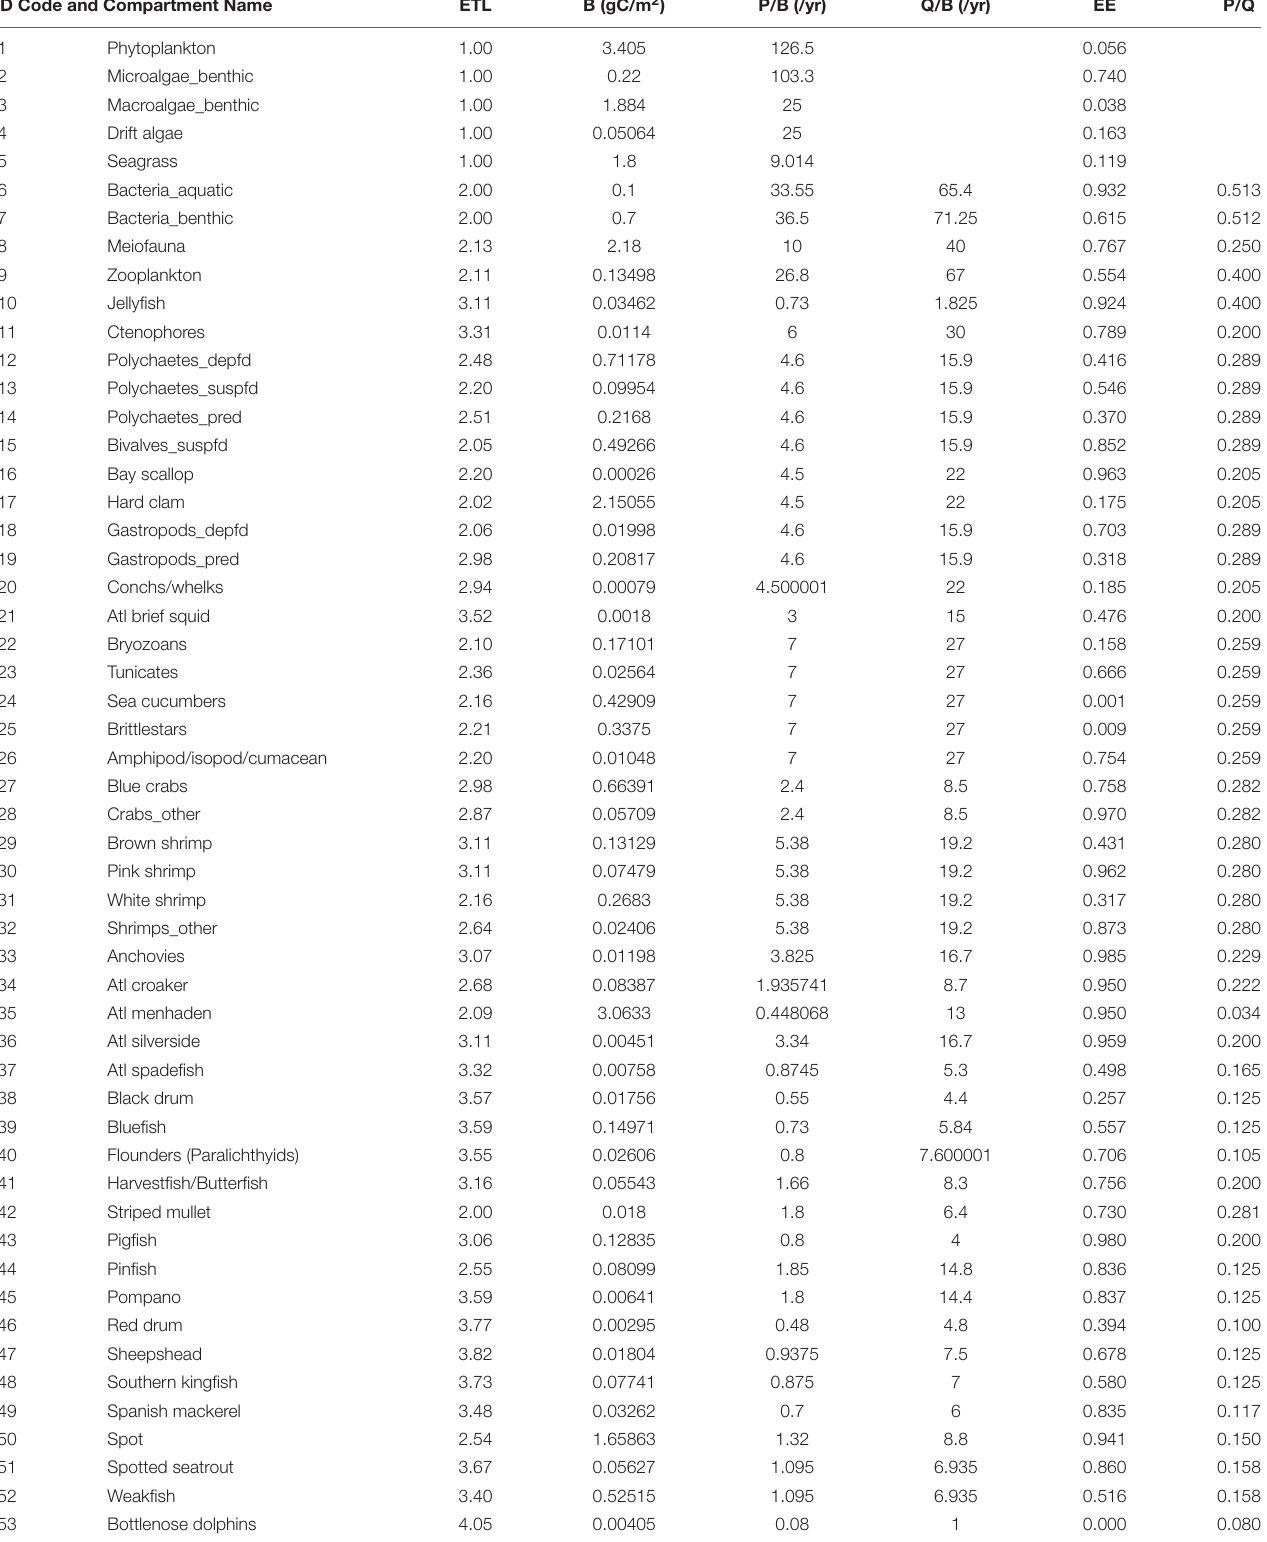
TABLE 1 | ECOPATH basic outputs for the balanced Core Sound annualized open trawling